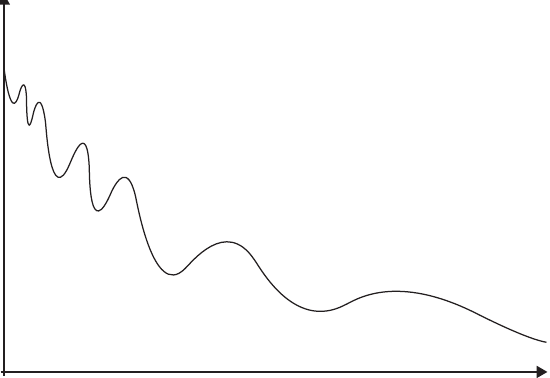
Figure 2: Negative bubble